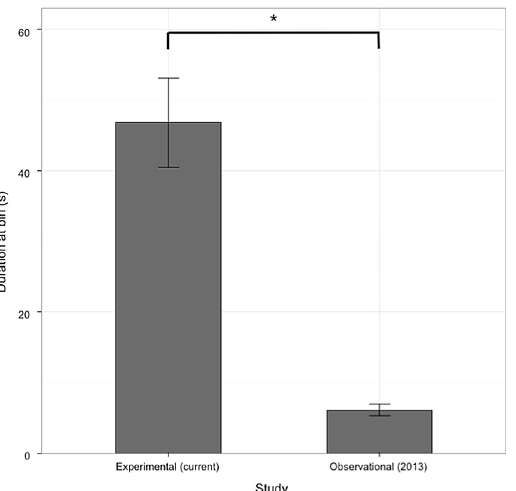
Fig 6. The duration of time spent at the receptacles in the current experimental study and in our observational study [26]. Participants spent significantly more time at receptacles in the current study compared to patrons in Wu et al.